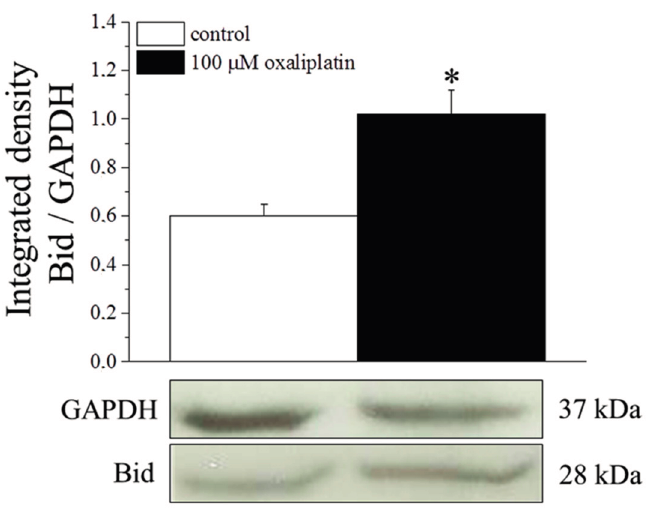
Figure 6. Bid protein expression. HT-29 (8 × 10 5 cells/flask) were incubated with 100 μ M oxaliplatin for 8 h and then cell lysates were analyzed by Western blot. Densitometric analysis ( top ) and representative immunoblot ( bottom ) are shown. GAPDH was used as loading control and GAPDH normalization was performed for each sample. Values are expressed as integrated density making the ratio between Bid and GAPDH specific band intensities. Bars represent the mean ± S.E.M. of three experiments. * p < 0.05 vs.